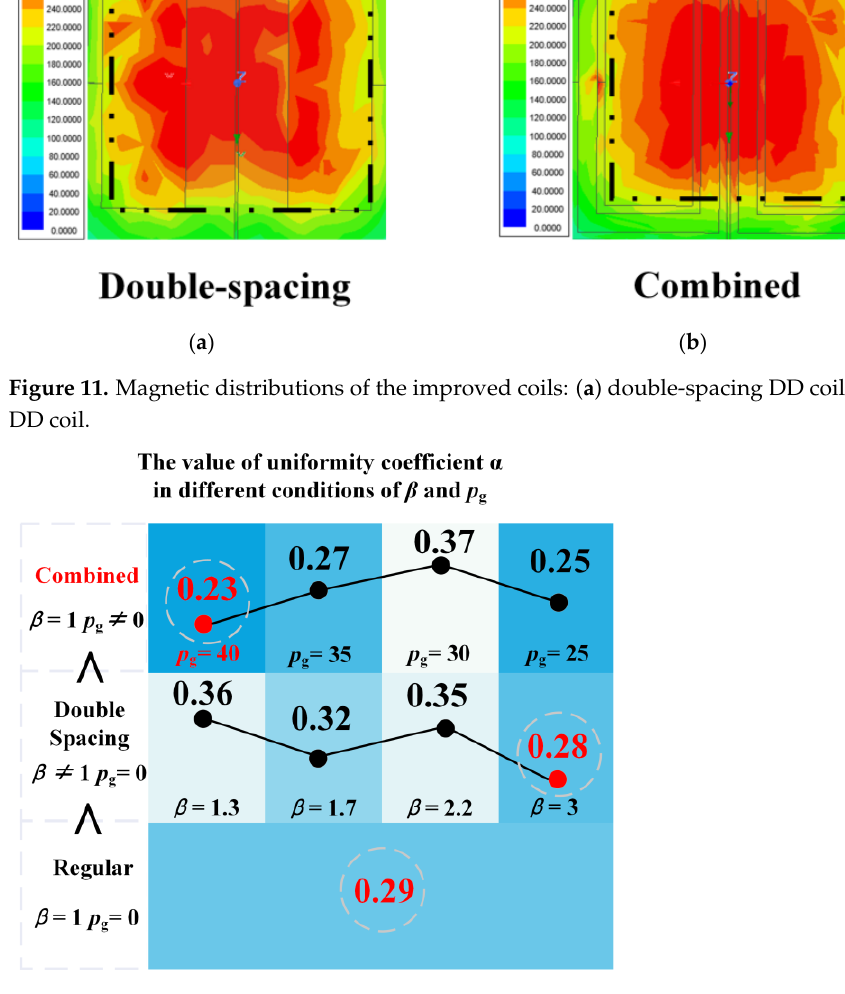
Figure 12. Values of the uniformity coefficient α under different conditions of β and p g.